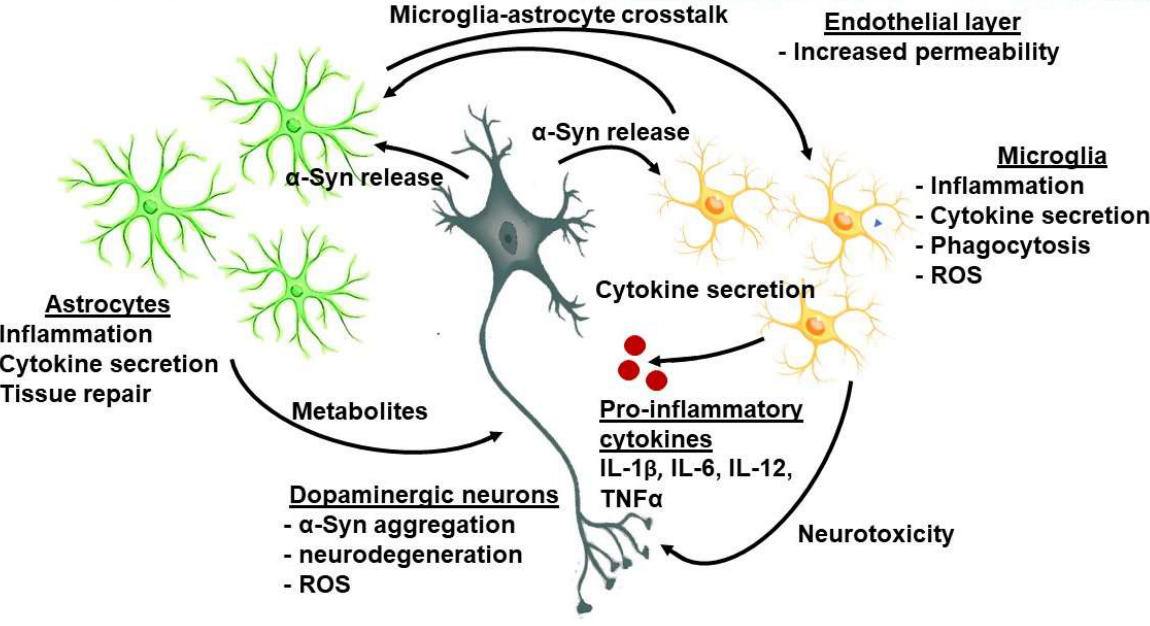
Figure 1. The complex interplay between cellular and molecular factors in PD-related neuroinflam- mation.